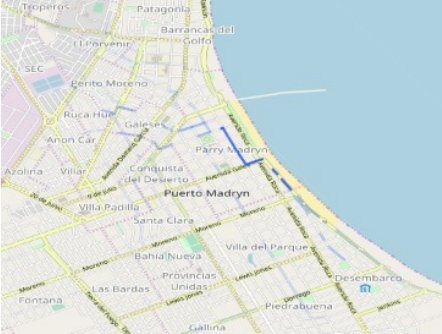
Figure 4. Journeys obtained with default values.